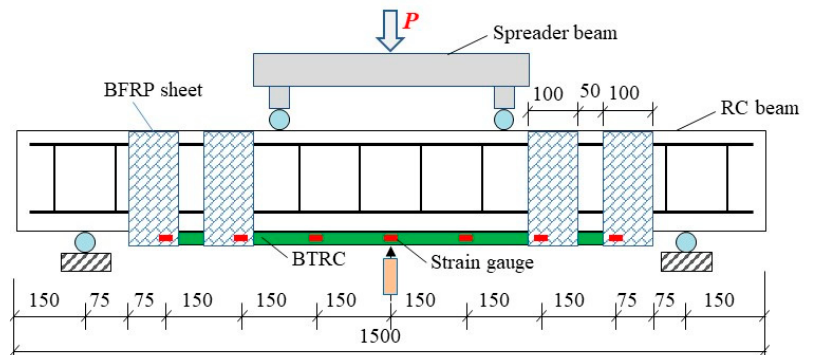
Figure 4. Test setup for bending tests.